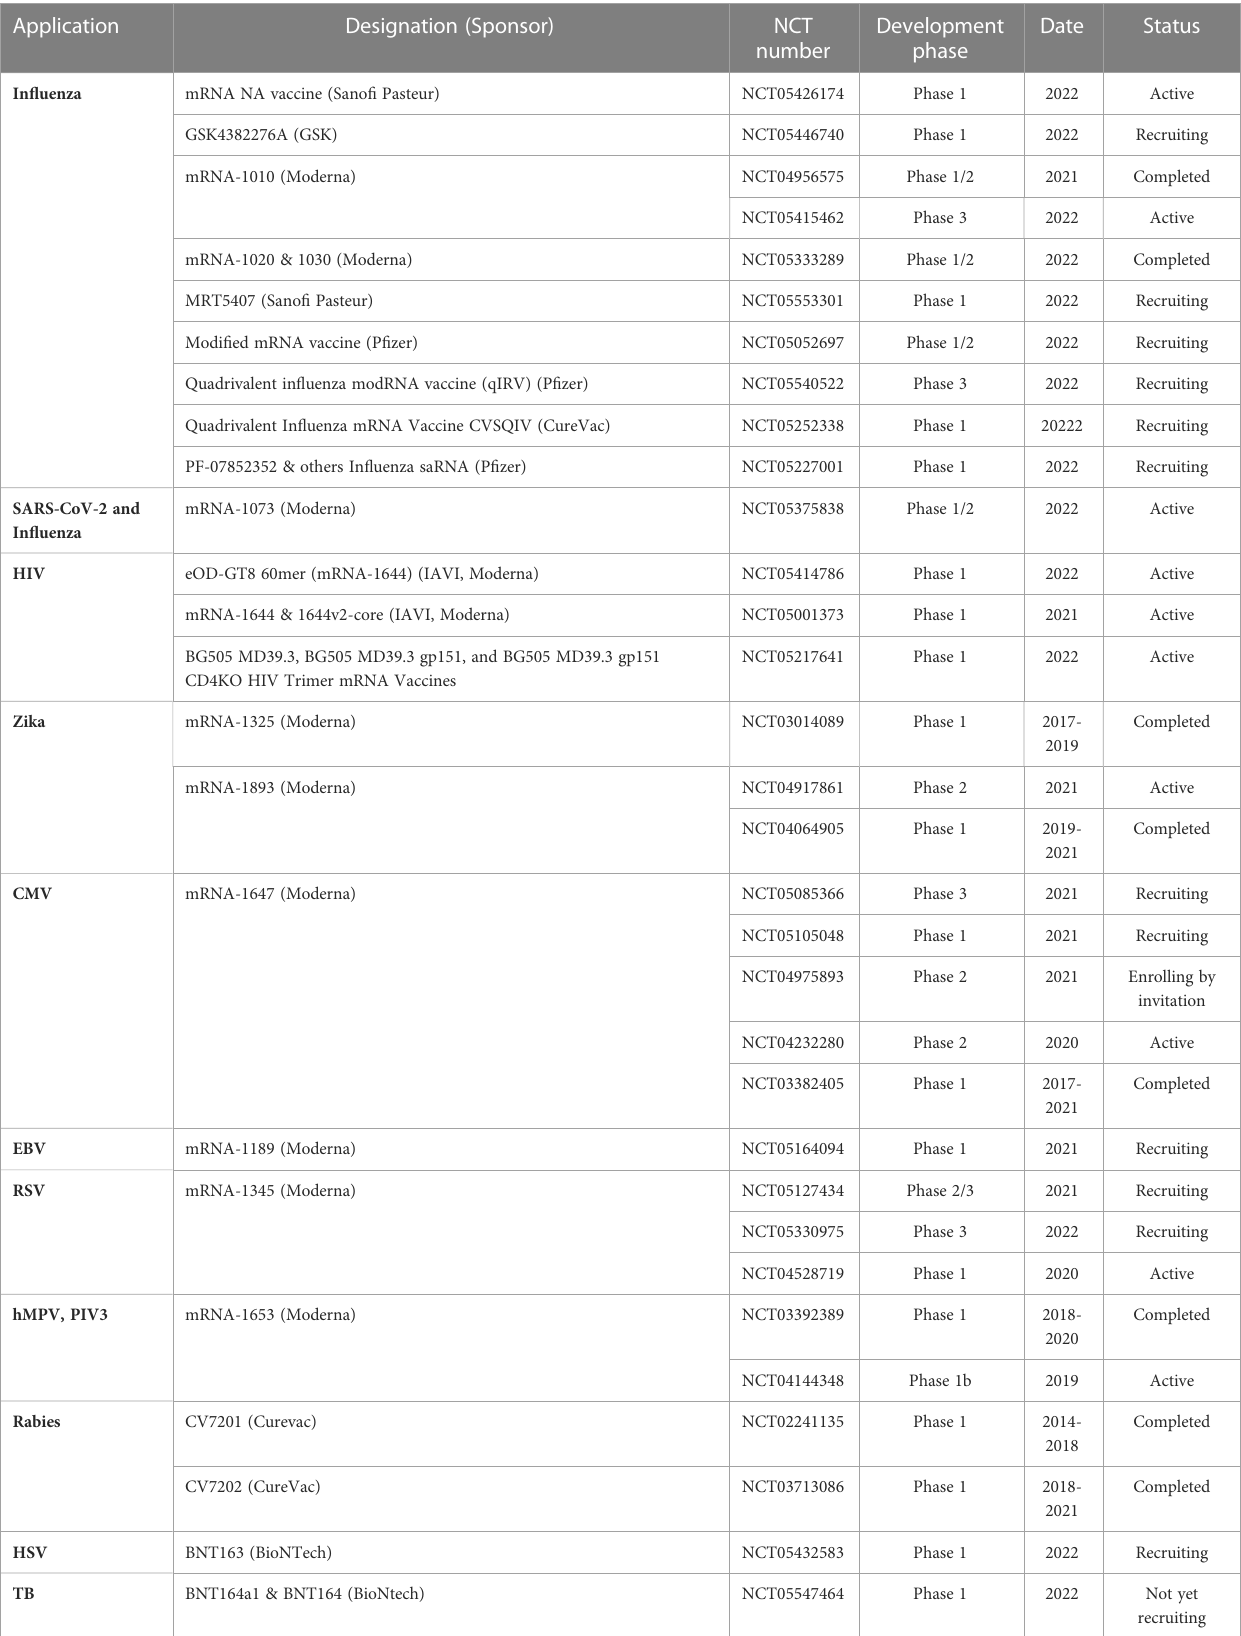
TABLE 1 list of clinical trials evaluating mRNA vaccines against infectious